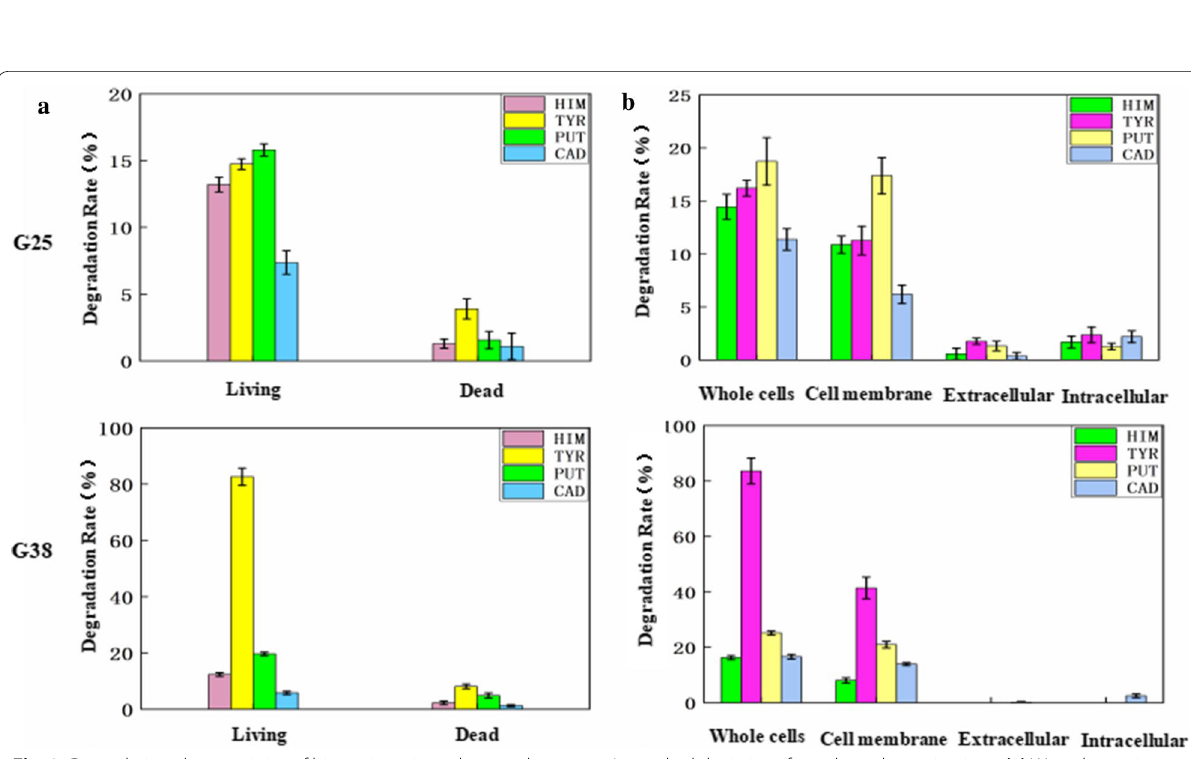
Fig. 3 Degradation characteristics of biogenic amines, data are the means degrade BAs (b) Localization of the